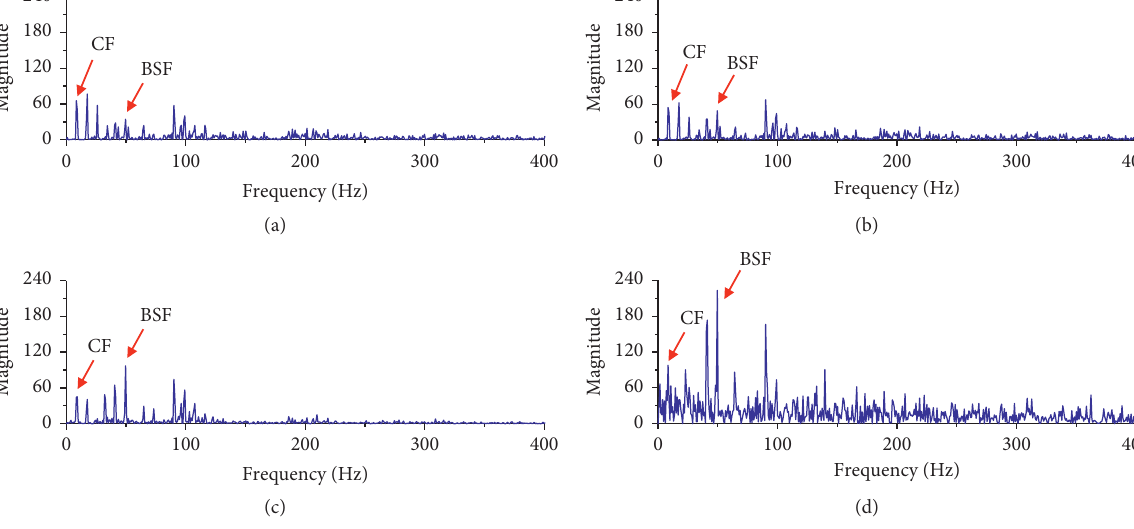
Figure 11: Processing result of the vibration signal induced by rolling element fault. (a) Envelope demodulation; (b) peak-based wavelet decomposition; (c) parameter-optimized peak-based wavelet decomposition; (d) proposed peak-based mode decomposition. Table 2: Comparisons of some major indictors for bearing fault